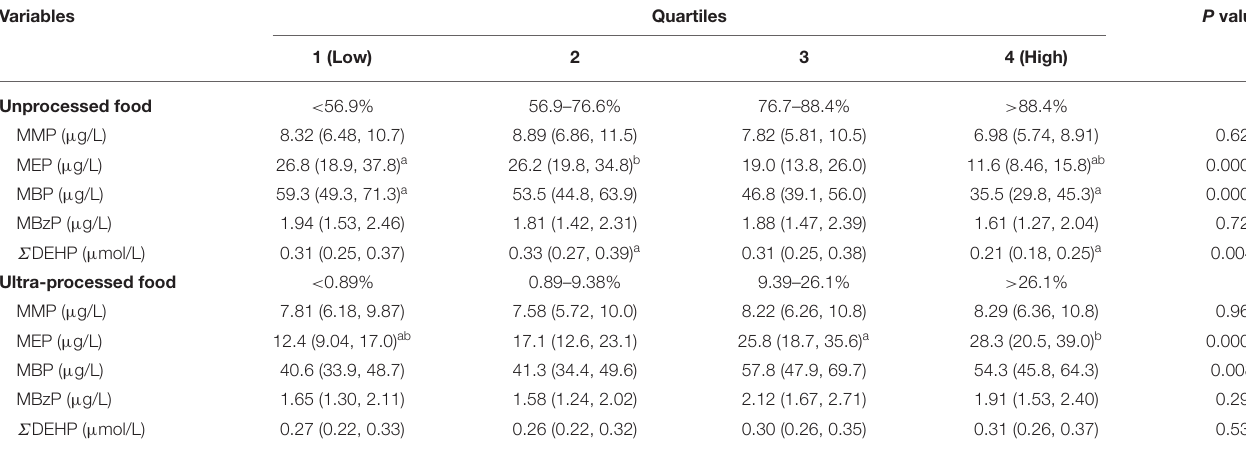
TABLE 2 | Geometric means (95% confidence interval) of urinary phthalate metabolites by quartiles of unprocessed and ultra-processed food intake ( n = 516). Variables